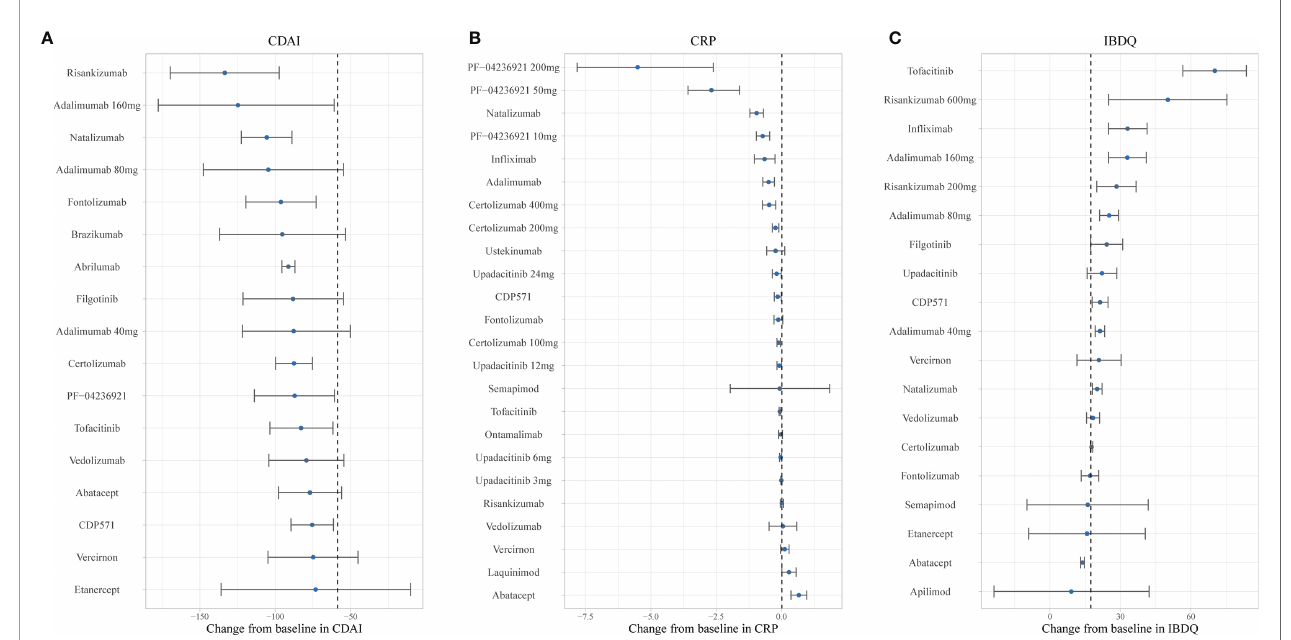
FIGURE 5 | Ranking of the treatments by predicted placebo-corrected median change in (A) CDAI, (B) CRP, and (C) IBDQ at week 12 (from high to low). Point estimates and 95% CIs were predicted from a model simulation of N = 10,000. Dashed lines represent simulated placebo ef fi cacy. For treatments with multiple dosage regimens, only regimens with different ef fi cacy at week 12 were listed separately. CDAI, Crohn ’ s Disease Activity Index; CRP, C-reactive protein; IBDQ, In fl ammatory Bowel Disease